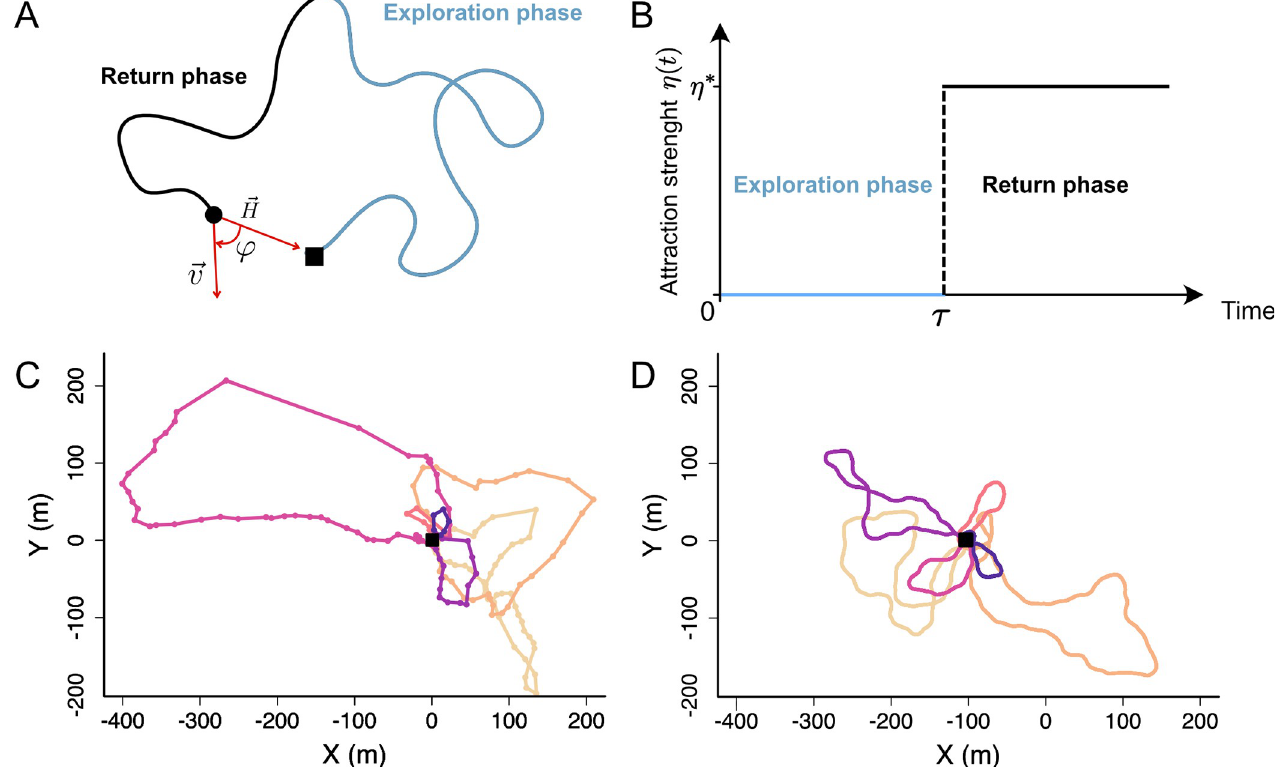
Fig 1. Illustration of the model. (A) Example of theoretical trajectory. Blue line: Trajectory during the exploration phase. Black line: Trajectory during the return phase. Black circle: bee. Black square: nest. H is the homing vector pointing towards the nest. ~ v is the velocity of the bee. φ is the angle between ~ v and ~ H . (B) Evolution of the return strength ( η ) over time. At time = τ , η switches from 0 (no attraction) to η * . (C) Example of an experimental trajectory [71]. Each dot represents the position of a bee recorded by a harmonic radar approximately every 3s. Different colors represent different flight loops around the nest. The sequential order of the loops is represented by the color gradient where the first loops have lightest colors (yellow to purple). (D) Same as C, but for a simulated trajectory with parameters γ = 1.0 s − 1 , σ = 0.37 rad/ s 1/2 , p return = 1/30 s − 1 and η * = 0.2 s -1 .